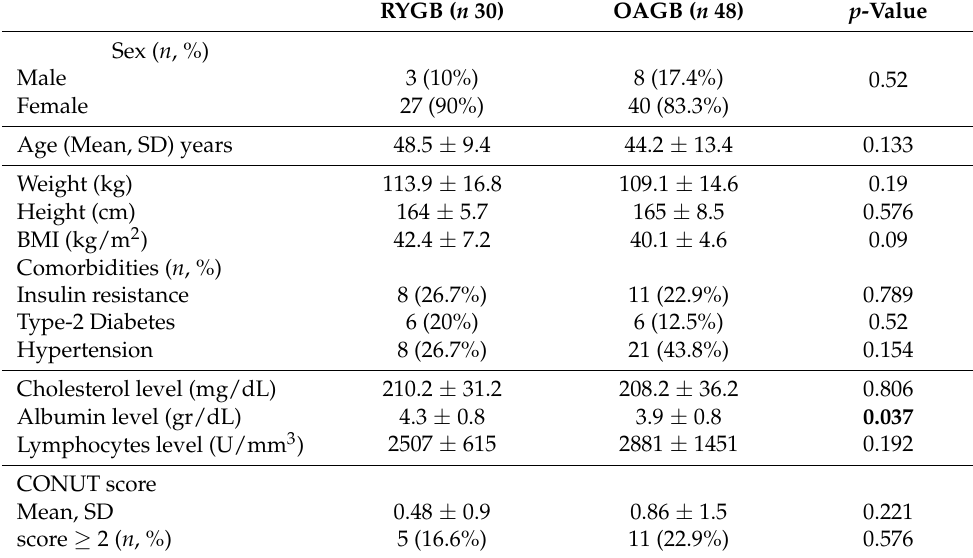
Table 3. RYGB and OAGB cohort pre-operative characteristics.